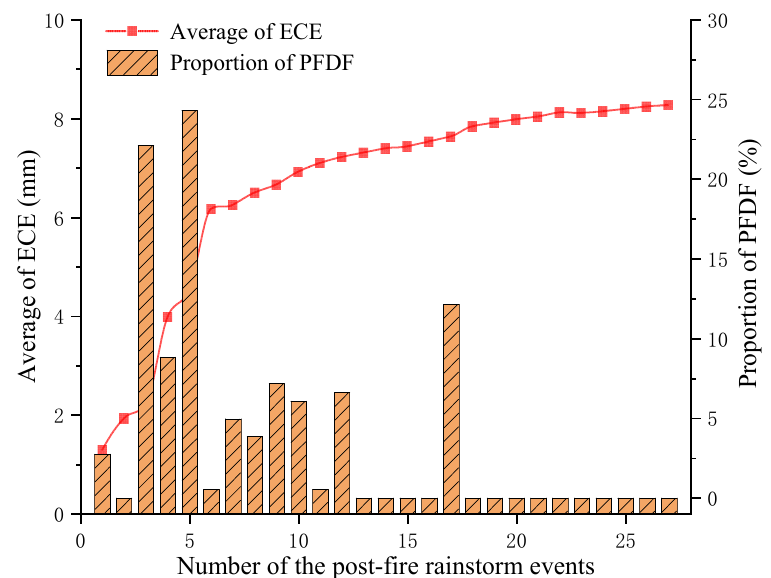
Figure 7. The temporal evolution laws of the average of ECE and occurrence frequency of PFDF in 27 rainfall events of the first rainy season after the fire in the study area.